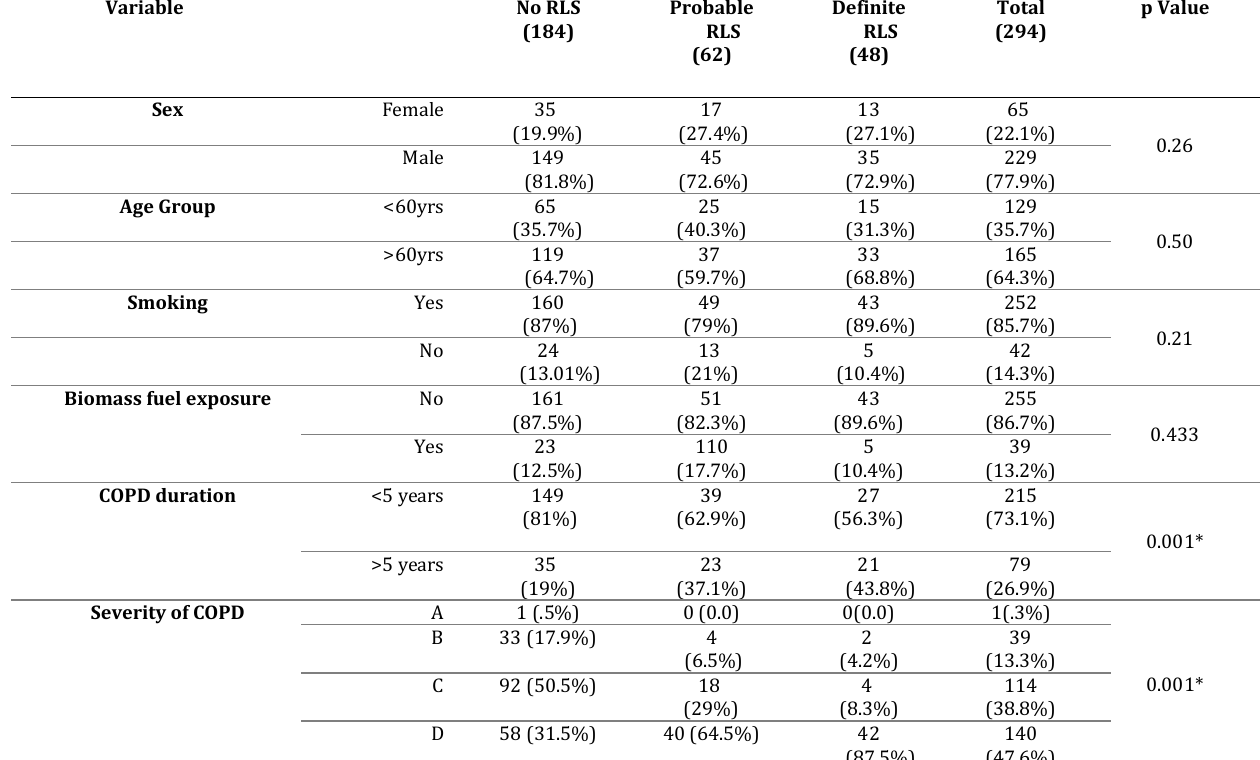
* Chi- square test (p value